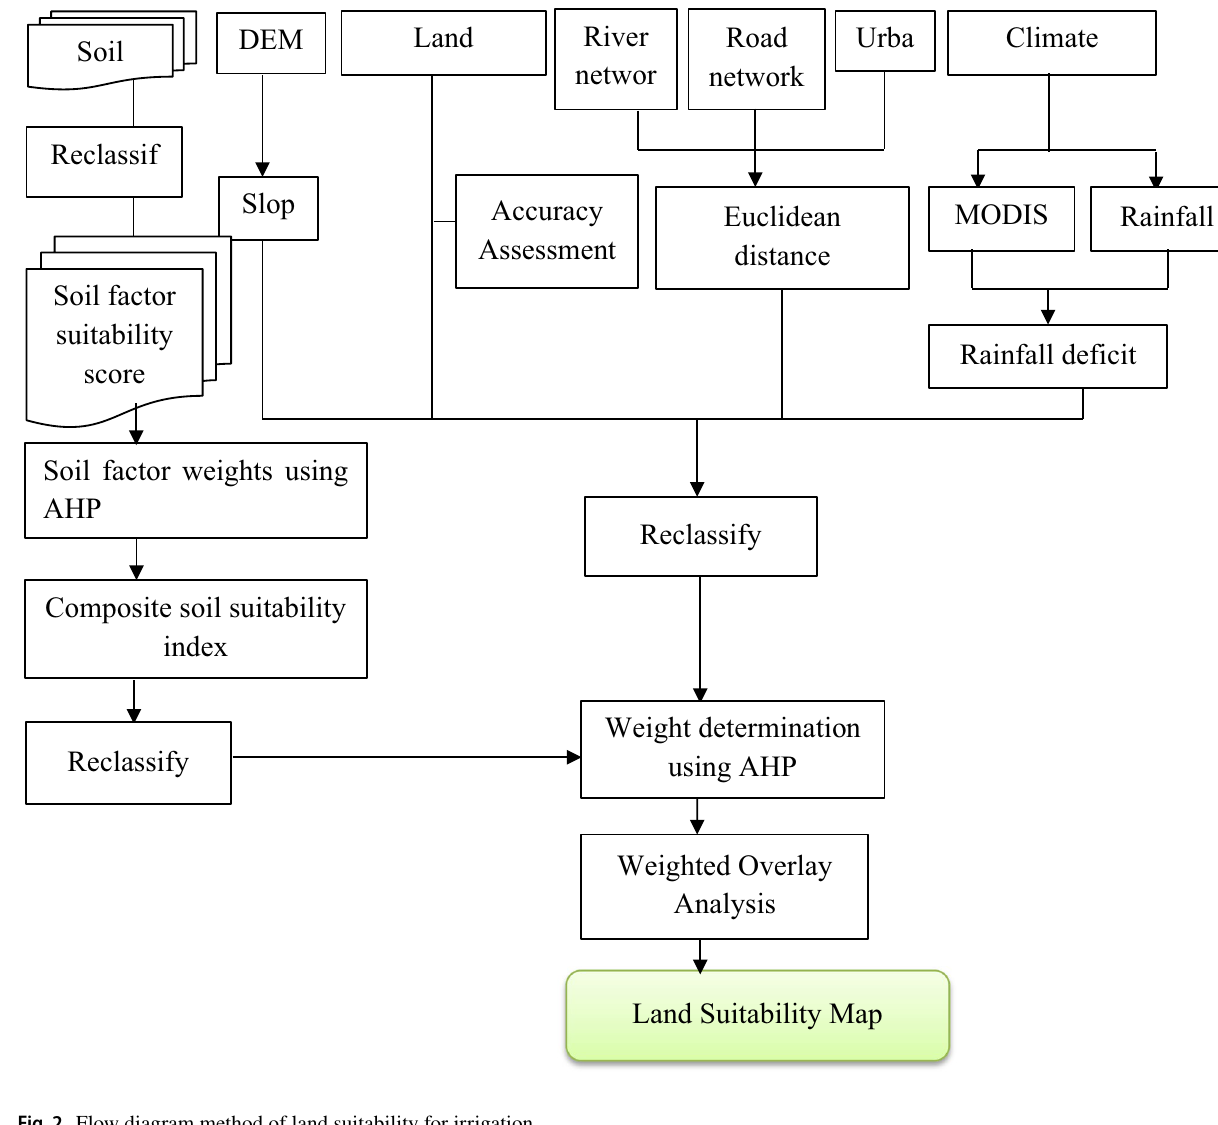
Fig. 2 Flow diagram method of land suitability for irrigation